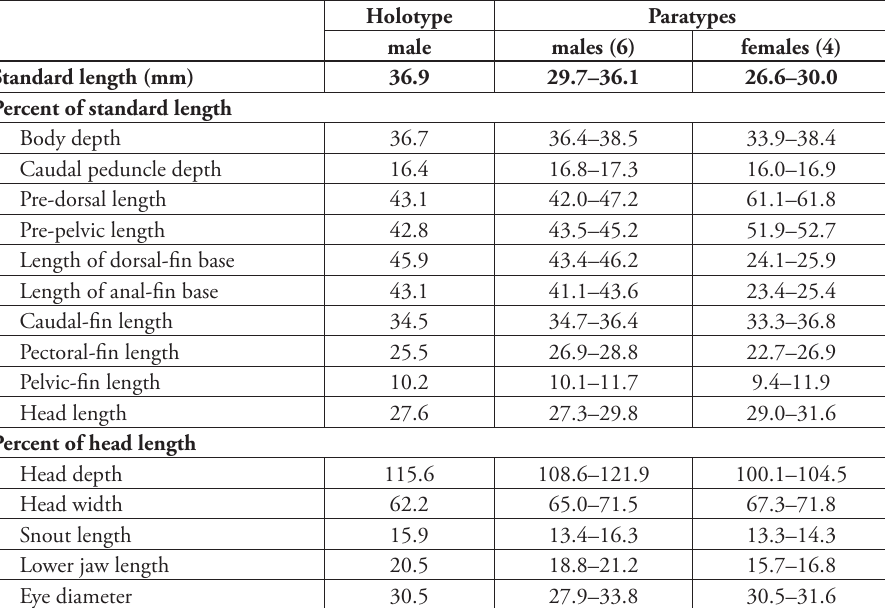
Table 2. Morphometric data of Hypsolebias gardneri sp.